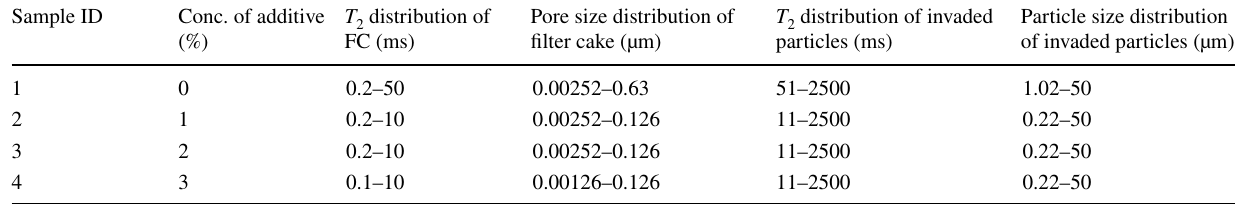
Table 3 Pore size distribution ( T 2 relaxation time) of filter cake and particle size distribution of invaded solids Sample